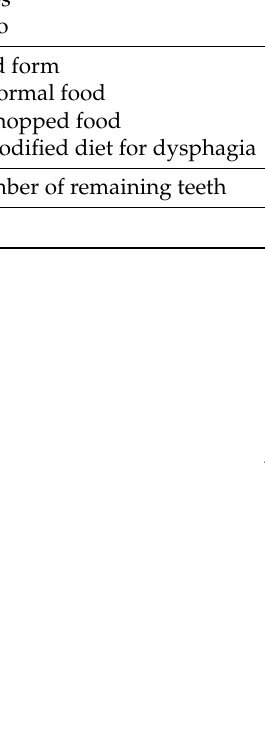
Table 3. Participant characteristics per active site ( n =